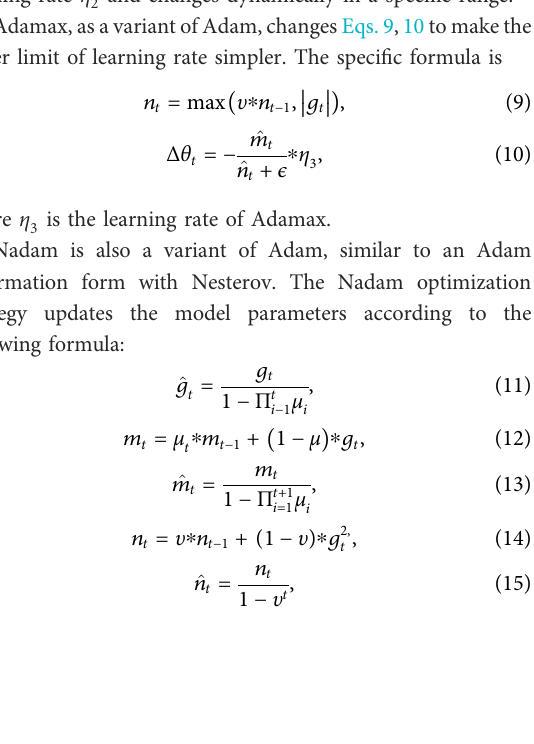
Frontiers in Earth